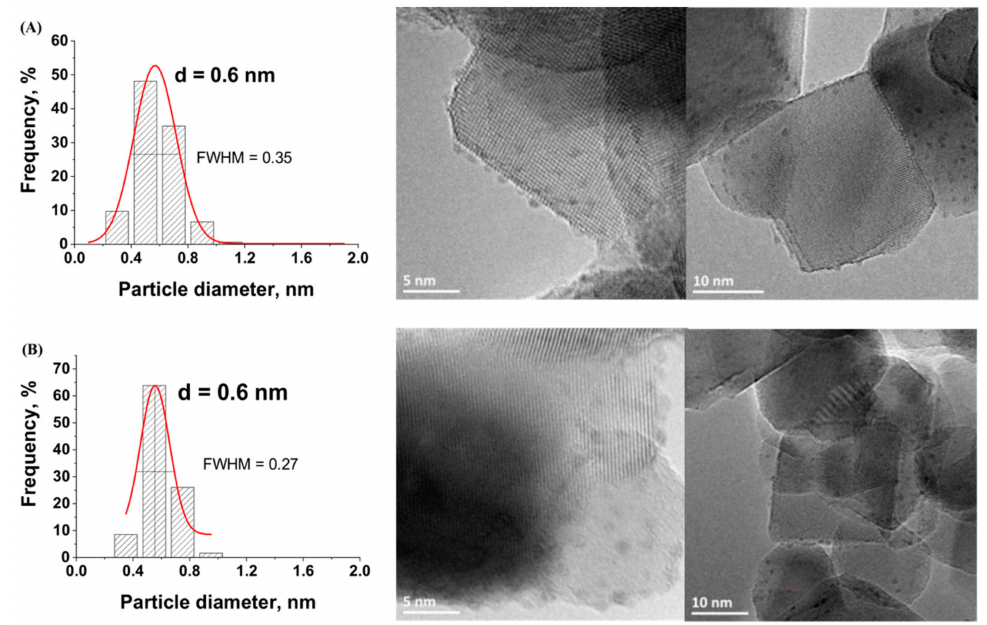
Figure 2. Transmission electron microscopy (TEM) images with the derived histograms of the Ru nanoparticle size distribution for the Ru(0.5 wt.%)/TiO 2 -P25 catalysts prepared from ( A ) acac and ( B )